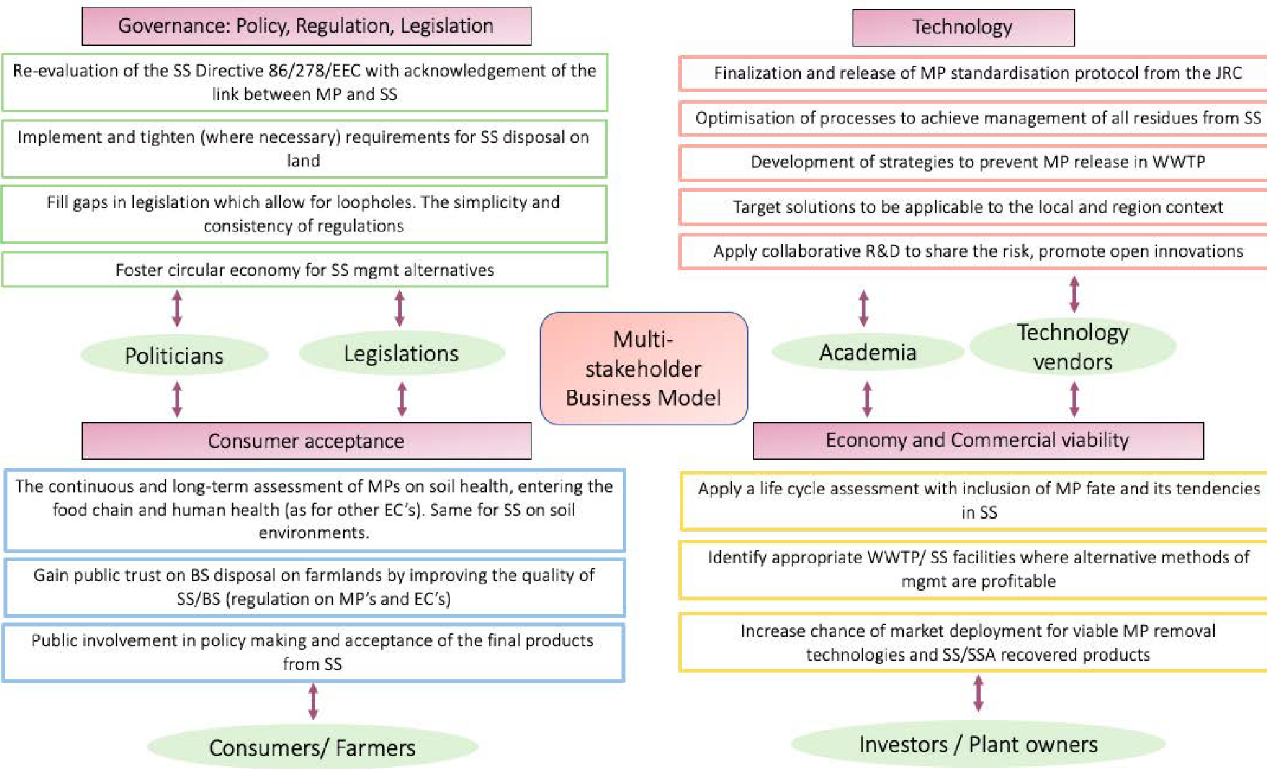
Figure 3. Proposed high-level strategy for sustainable sewage sludge management, specifically for the EU, SS—Sewage Sludge|MP—Microplastic|Mgmt—Management|WWTP—Wastewater treatment plant|SSA—Sewage Sludge Ash|JRC—Joint Research Centre|R&D—Research and Development.